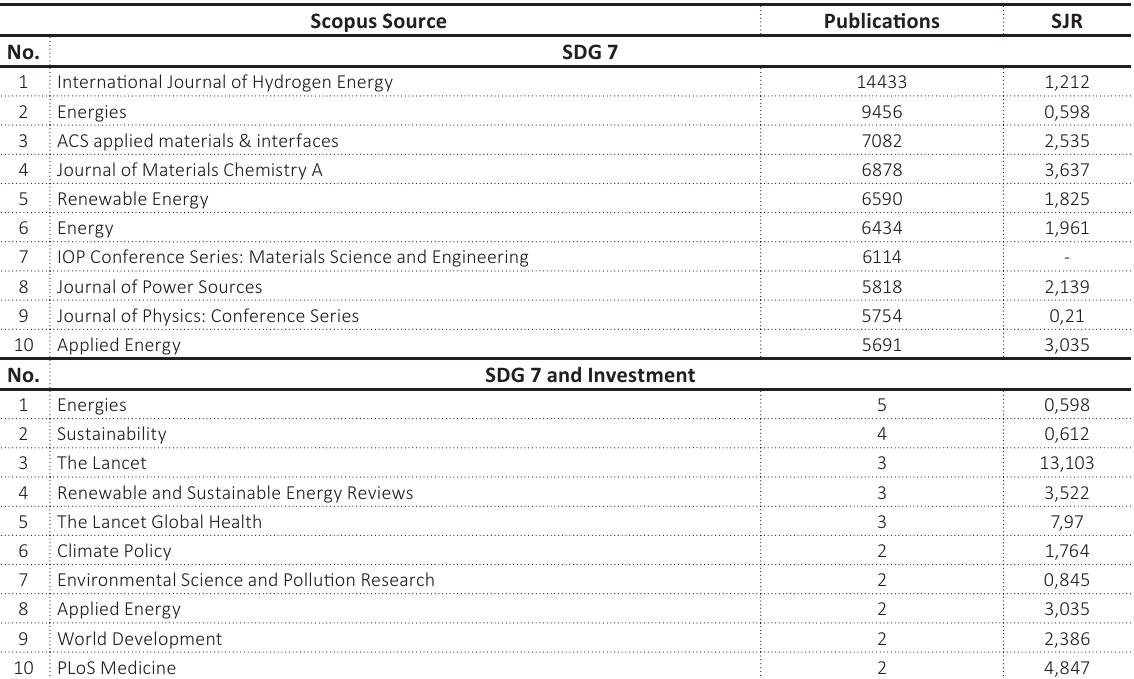
Table C1. Top 10 journals by scholarly output in each Research Area in 2016–2022